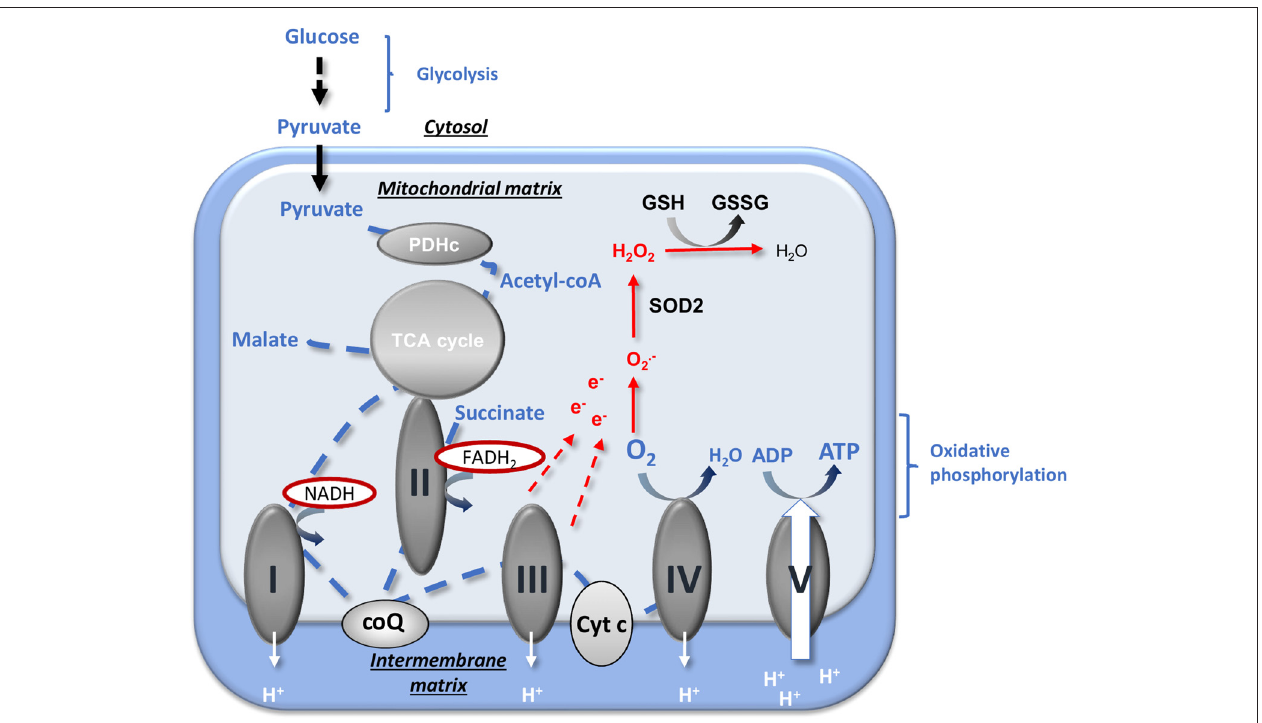
FIGURE 1 | Mitochondrial energy production and reactive oxygen species (ROS) regulation. Pyruvate from an aerobic glycolysis is converted by pyruvate dehydrogenase complex (PDHc) into acetyl-coA that enters into the tricarboxylic acid (TCA) cycle. The reducing equivalents NADH and FADH 2 produced are used by the respiratory chain (RC) complexes (complexes I, II, III and IV) to reduce O 2 (« respiration ») and to create the proton gradient necessary to ATP production by complex V. The oxidative phosphorylation is the coupling between ADP phosphorylation and the electron transport. The production of anion superoxide O 2. − is inherent to mitochondrial respiration because of the proximity between free electrons and O 2 . ROS detoxification is provided by the SOD2 that catalyzes the dismutation of O 2. − into H 2 O 2 and by GSH that allows the reduction of H 2 O 2 into H 2 O. CoQ, ubiquinone; Cyt c, cytochrome c; e − , electron; GSH, reduced glutathione; GSSG, oxidized glutathione; O 2. − , anion superoxide; PDHc, pyruvate dehydrogenase complex; SOD, superoxide dismutase; TCA, tricarboxylic acid. Adapted from Gaignard et al.